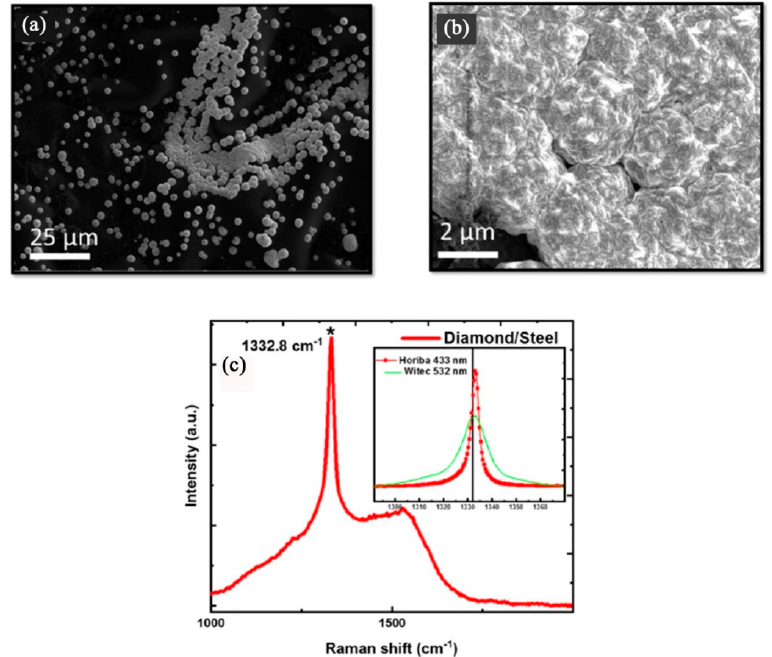
Figure 4. Microdiamonds can formed on steel substrates by hot-filament chemical vapor deposition (CVD), using the Q-carbon seeds formed after single-pulse pulsed laser annealing at 1.1 J/cm 2 : ( a ) SEM micrograph ( b ) The enlarged SEM micrograph and ( c ) Raman spectrum of the formed microdiamonds. (Reproduced with permission from [44]).